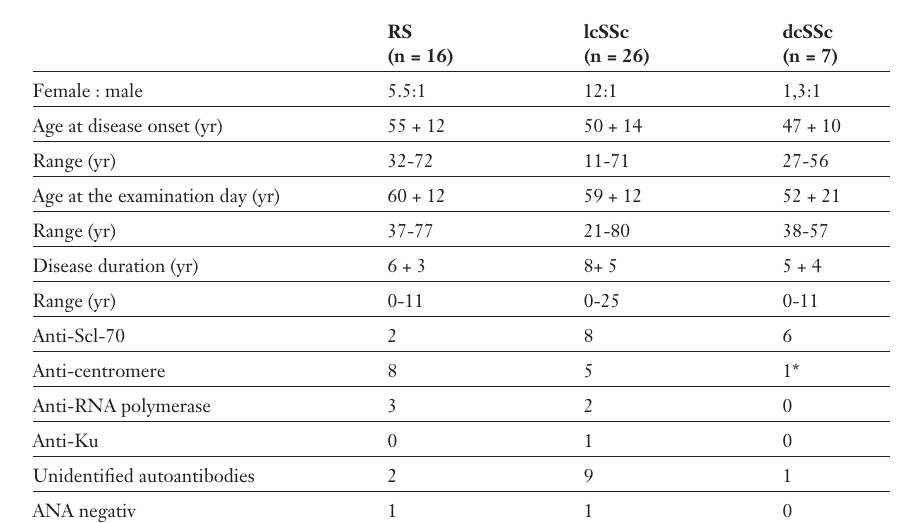
Characteristics of pa- tients with Raynaud syndrome (RS), limited cutaneous systemic sclerosis (lcSSc) or diffuse cutaneous systemic sclerosis (dcSSc) fulfilling the ACR 1980 classification at assessment. Number of patients with different